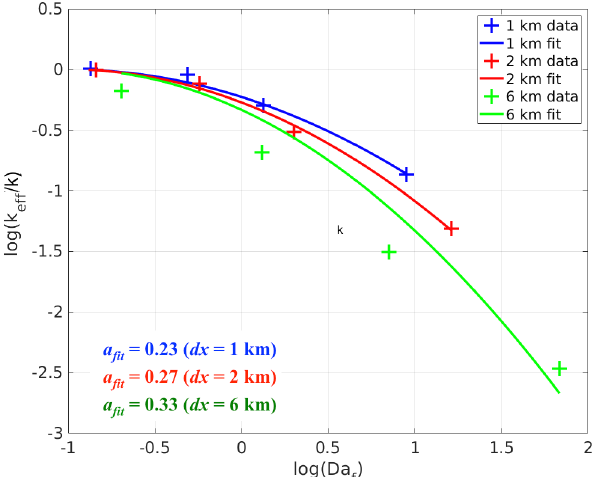
Figure 6. Fitted curves of the normalised boundary-layer-averaged effective chemical reaction rate k eff /k against the final Damköh- ler numbers Da f for the simulations with heterogeneous emissions with different lengths of heterogeneity (d x ). a fit refers to the fitted slope for the square law between log (k eff /k) and log (Da f ) corre- sponding to different d x values.